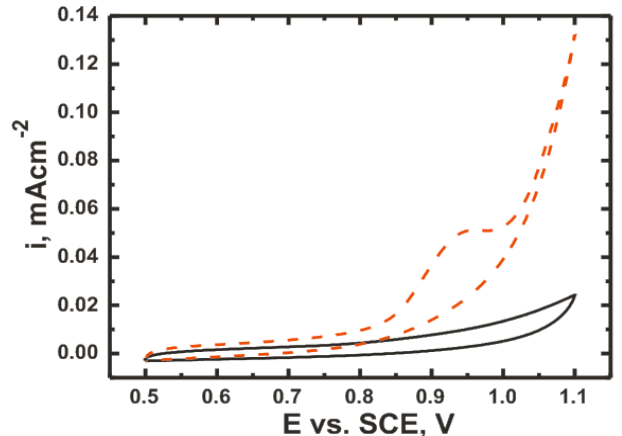
Figure 4. Comparison of cyclic voltammetry responses of 4-ABA films deposited on GCE (solid line) and stainless steel (dashed line) recorded in 0.5 mol dm -3 K SO . Scan rate, 50 mV s -1 . 2 4